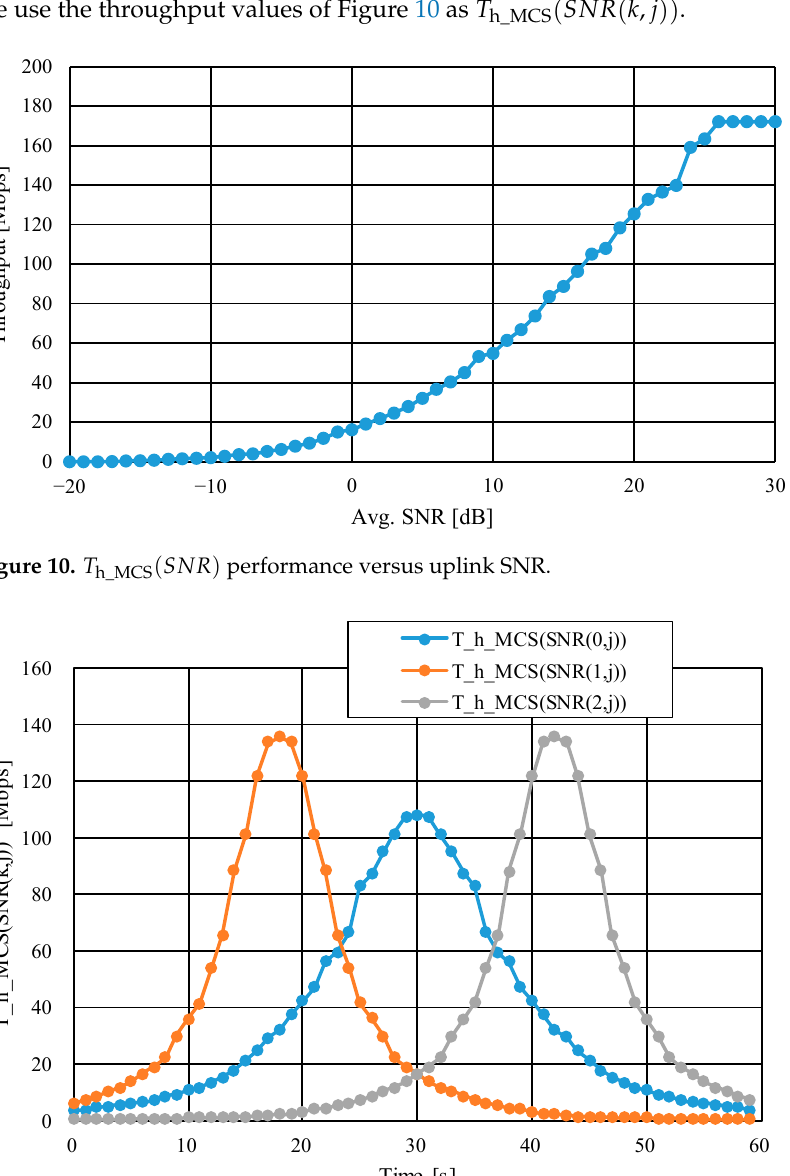
Table 4. Simulation conditions of other user throughputs.